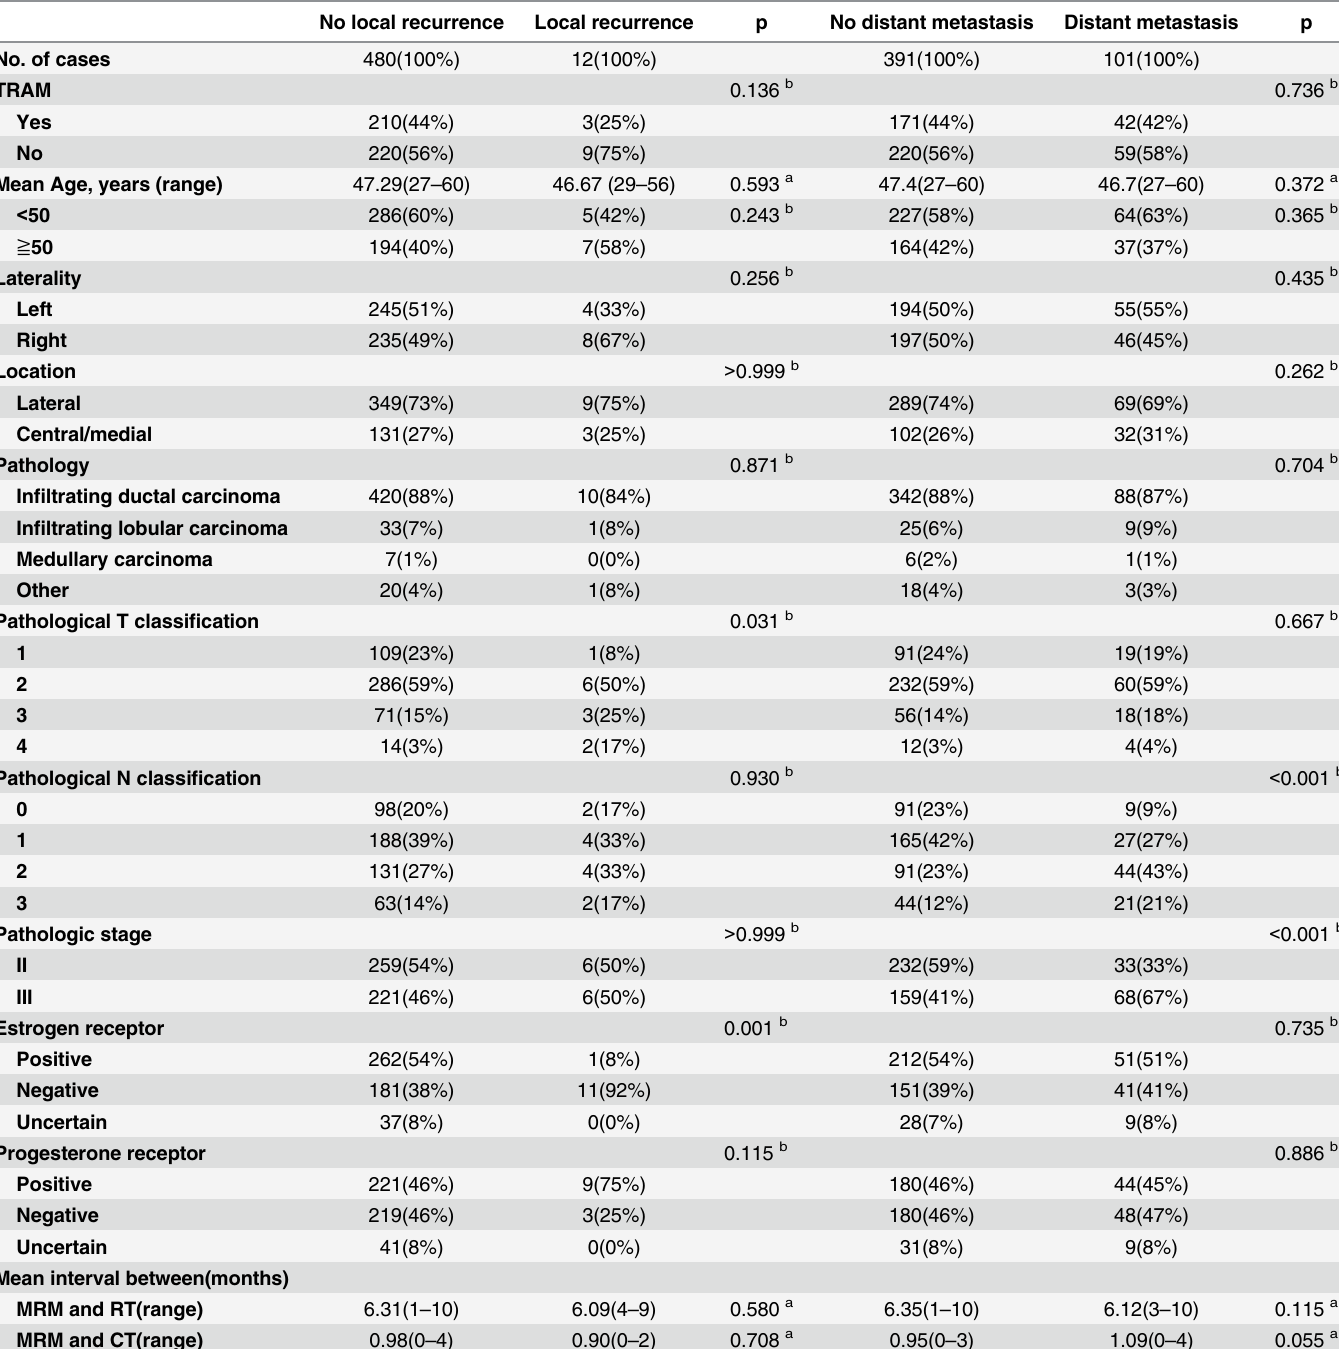
Table 2. Univariate analyses for risk factors of local recurrence and distant